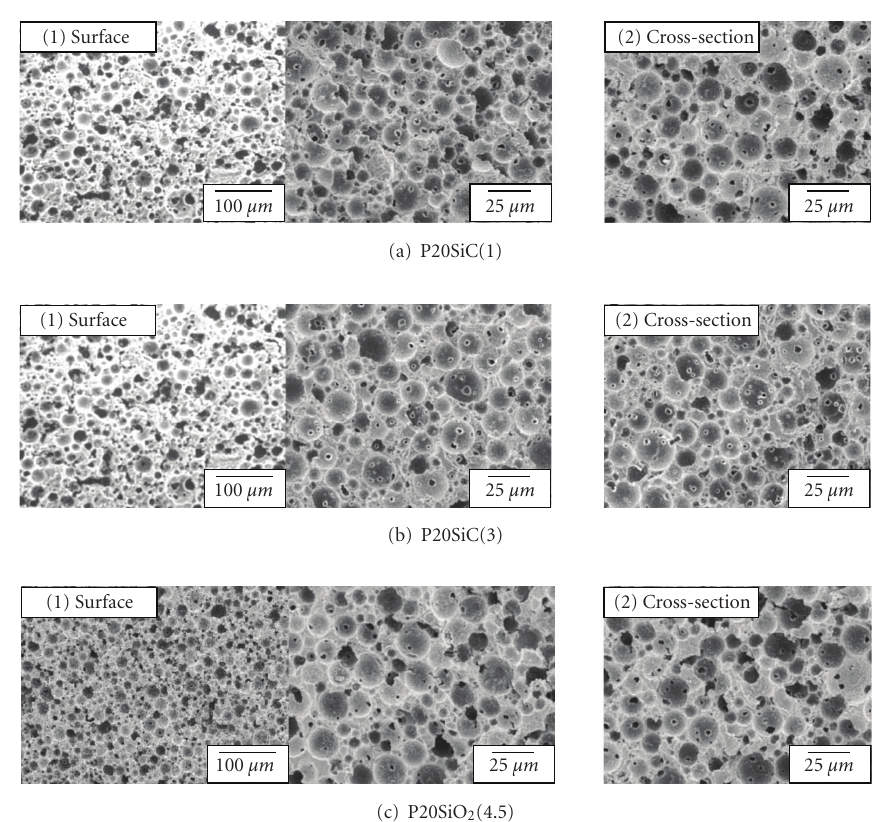
Figure 6: SEM photographs of (a) P20SiC(1), (b) P20SiC(3), and (c) P20SiO 2